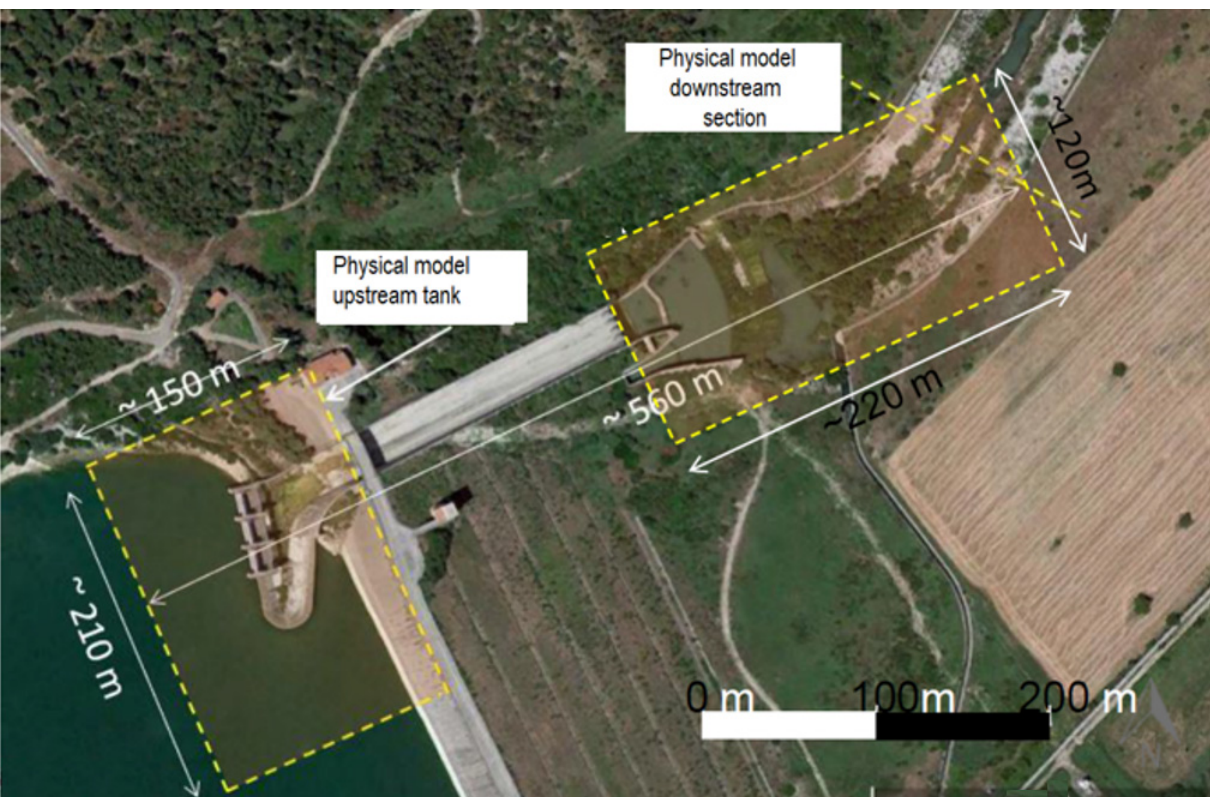
Figure 4. Area reproduced with the physical model.